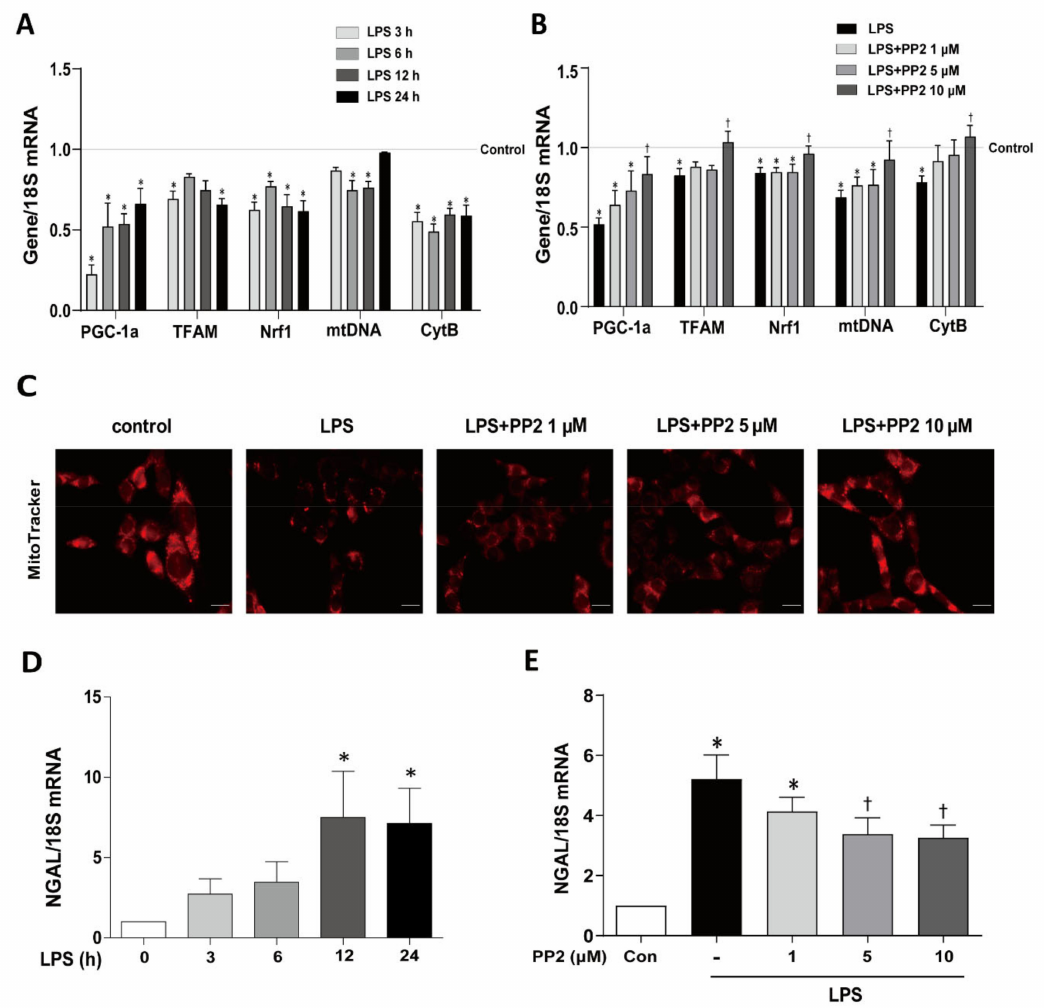
Figure 1. PP2 maintains mitochondrial biogenesis in mProx cells. ( A , D ) The mProx cells were stimulated with lipopolysaccharides (LPS) in a time-dependent manner (0, 3, 6, 12, and 24 h). ( A ) The mRNA levels of mitochondrial fitness markers such as PGC-1 α , TFAM, Nrf1, mtDNA, and CytB were measured. ( B , C , E ) The cells were pretreated with PP2 (0, 1, 5, and 10 µ M) for 2 h and then stimulated with LPS (100 ng / mL) for 9 h. ( B ) The mRNA levels of PGC-1 α , TFAM, Nrf1, mtDNA, and CytB were measured. ( C ) The mitochondria in mProx cells were labeled with MitoTracker staining. ( D ) The mRNA levels of NGAL were measured in mProx cells after LPS (100 ng / mL) stimulation in a time-dependent manner (0, 3, 6, 12, and 24 h). ( E ) The mRNA levels of NGAL were measured. The levels of mRNA expression were measured using real-time RT-PCR analysis and normalized with 18S. Data are presented as mean ± SE, n = 4. * p < 0.05 vs. control. † p < 0.05 vs.